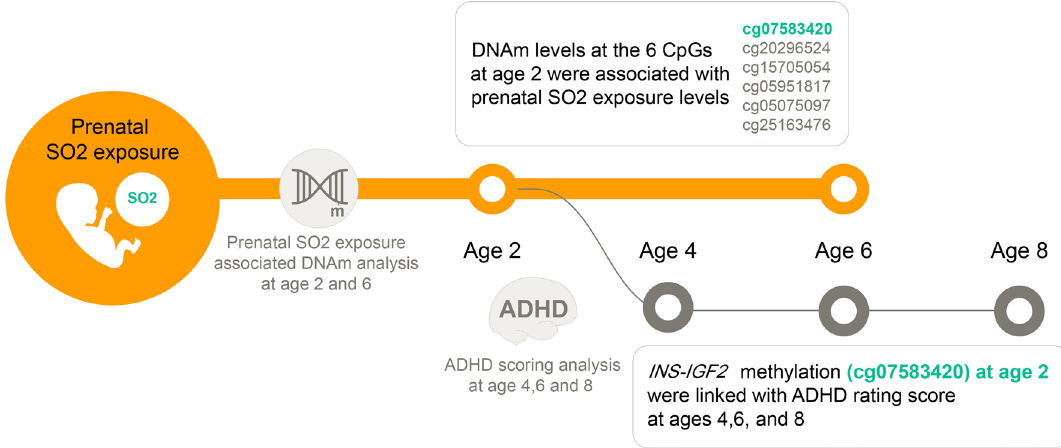
Figure 5. The overview of the study design and results (Candidate gene